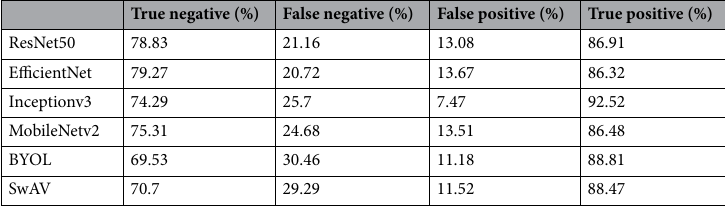
Table 2. Average confusion metrics obtained by six CNN models included in DUNEScan